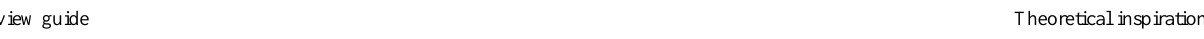
Theoretical inspirationInterview guide